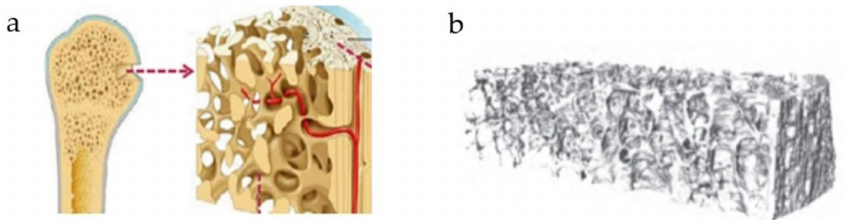
Figure 1. Schematic diagram of bone tissue: ( a ) Hierarchical structural organization of bone; ( b ) Mi- crostructure of human